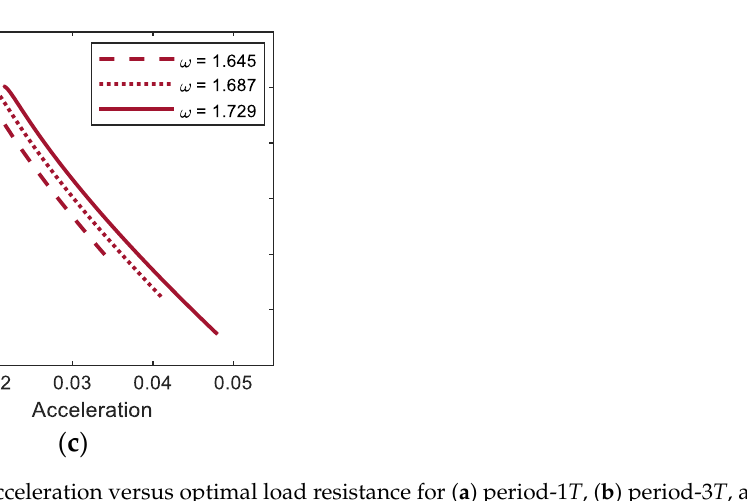
Figure 10. Base acceleration versus optimal load resistance for ( a ) period-1 T , ( b ) period-3 T , and ( c ) period-5 T motions of the bi-stable electromagnetic energy harvester.